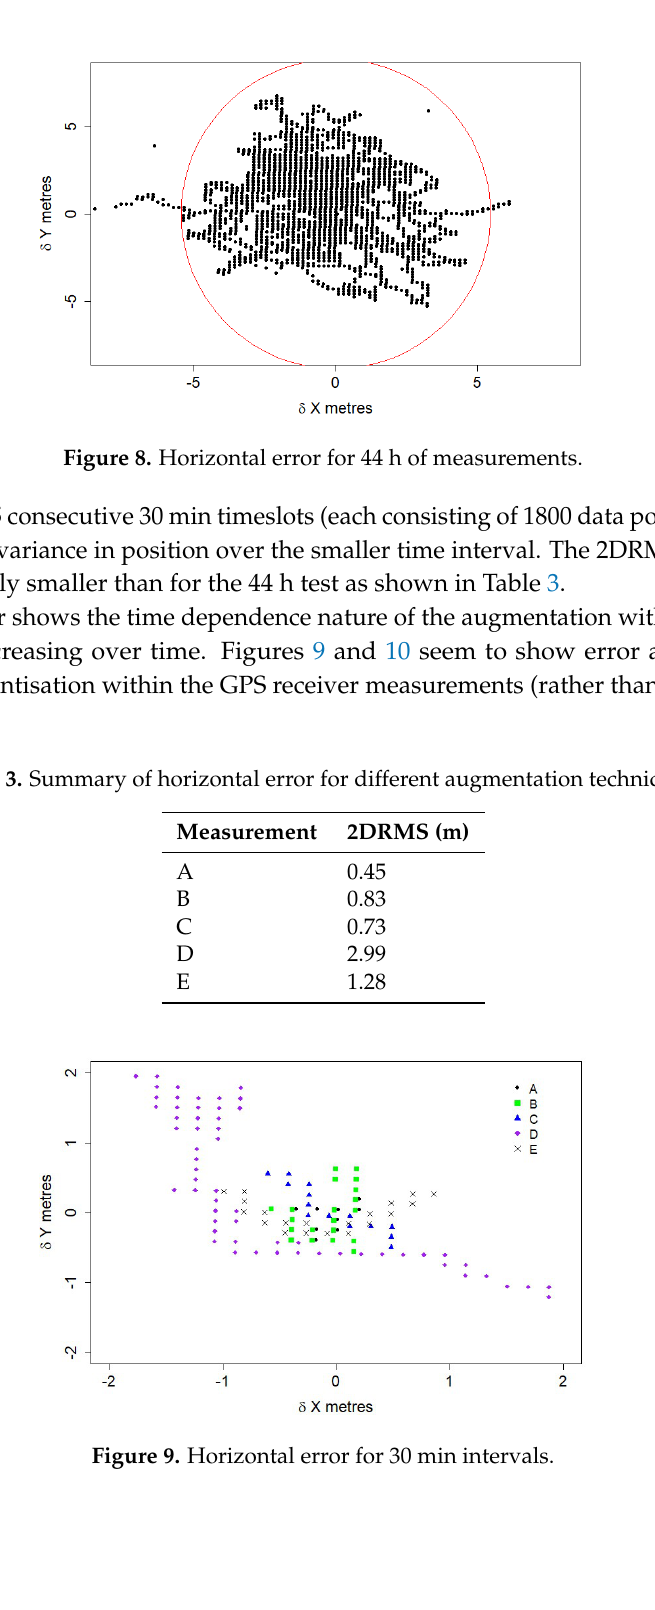
Figure 9. Horizontal error for 30 min